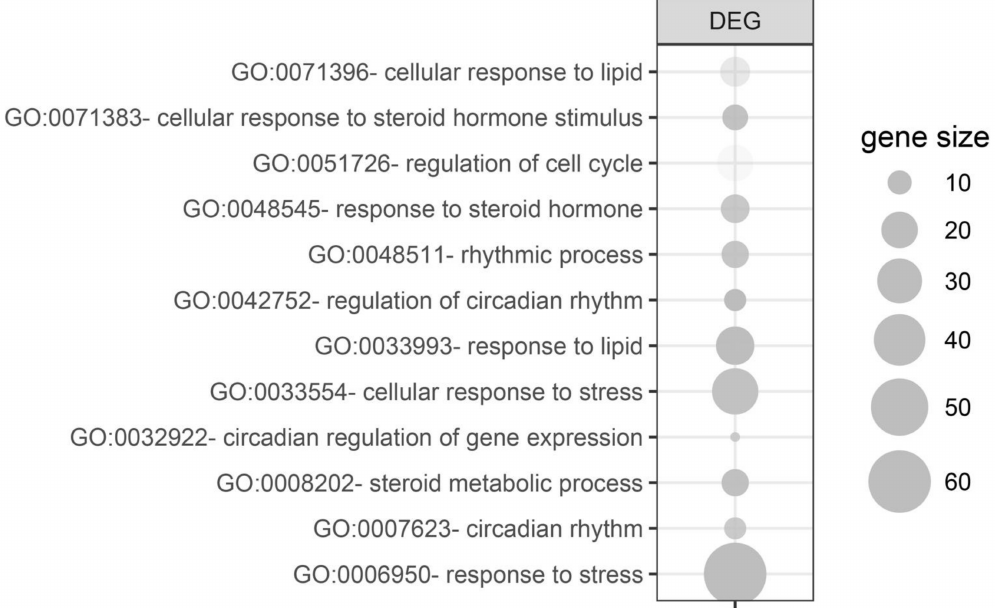
Figure 5. Gene ontological (GO) groups relevant to adrenal physiology, selected by searching the DAVID GOTERM BP database using all of the differentially expressed genes (both from 24 h/control and 72 h/control comparisons). The graphs show only the GO groups above the established cut-off criteria ( p with correction <0.05, a minimal number of genes per group >5). The size of each bubble reflects the number of differentially expressed genes assigned to the GO terms. The transparency of the bubbles displays the p -values (more transparent is closer to the border of p =